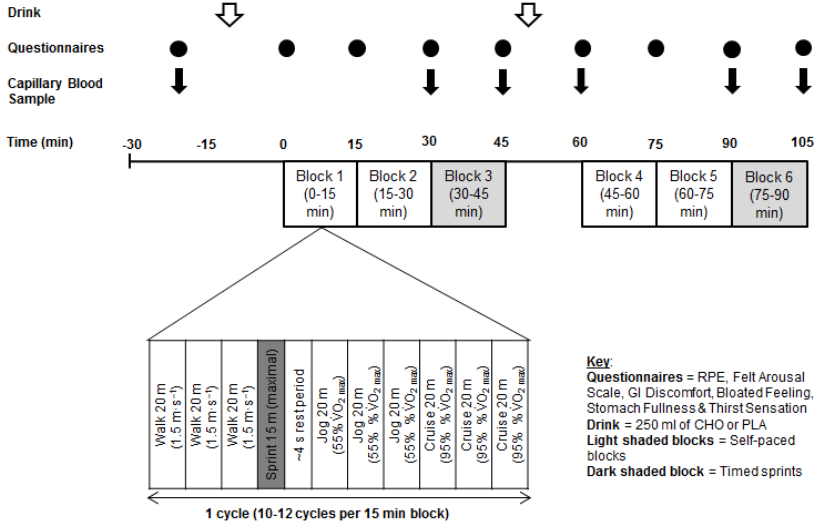
Figure 1. Schematic of the study design.